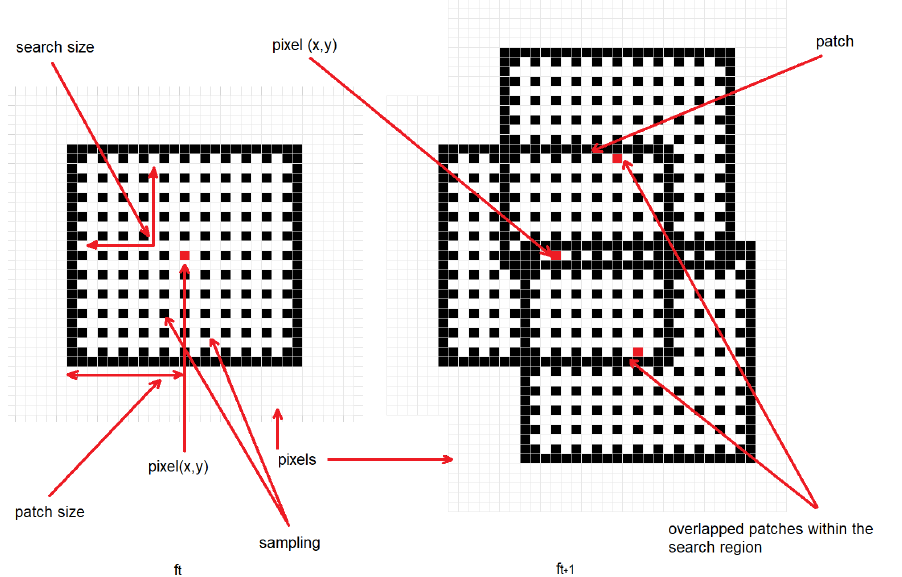
Figure 5. The proposed optical flow algorithm formulation: patch size = 10, search size = 10, and sampling value = 2. For each pixel in the reference image f t , n overlapped regions are constructed in f t + 1 , and the n region center that minimizes or maximizes any similarity metric is the tracked position (flow) of the pixel ( x , y ) at f t + 1